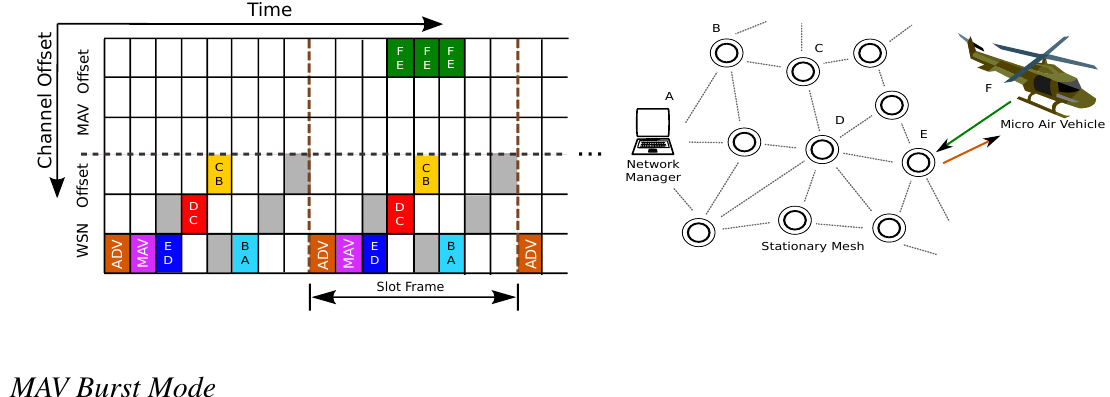
Figure 4. If the MAV has a small amount of data to send, it can request a number of slots to communicate to its nearest neighbor in the mesh. These slots can be predetermined by the manager or stationary nodes. That data then gets routed over the mesh as would any other data generated in the